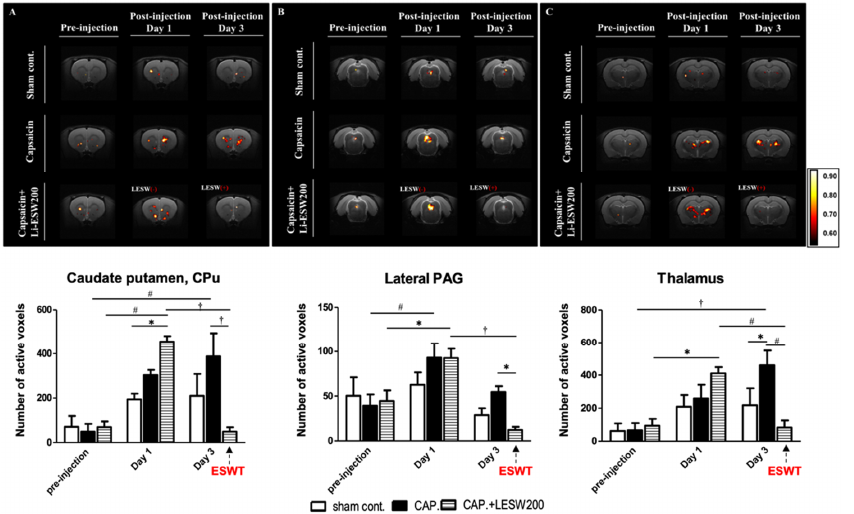
Figure 6. BOLD fMRI signal changes over time with or without Li-ESWT in capsaicin-induced prostatitis rats. Shown here are activation maps of BOLD signal changes in ROI includes ( A )caudate putamen; ( B )lateral PAG and ( C )thalamus. One day after capsaicin injection, positive BOLD signal changes increased in caudate putamen, lateral PAG, and thalamus. In Li-ESWT treated rats, the number of active voxels in these three pain-related ROI was significantly decreased by day three. However, in rats without having Li-ESWT, the active voxels in caudate putamen and thalamus continue to increase by day 3. ( n = 8 per group; * p < 0.05; # p < 0.01; † p < 0.001).